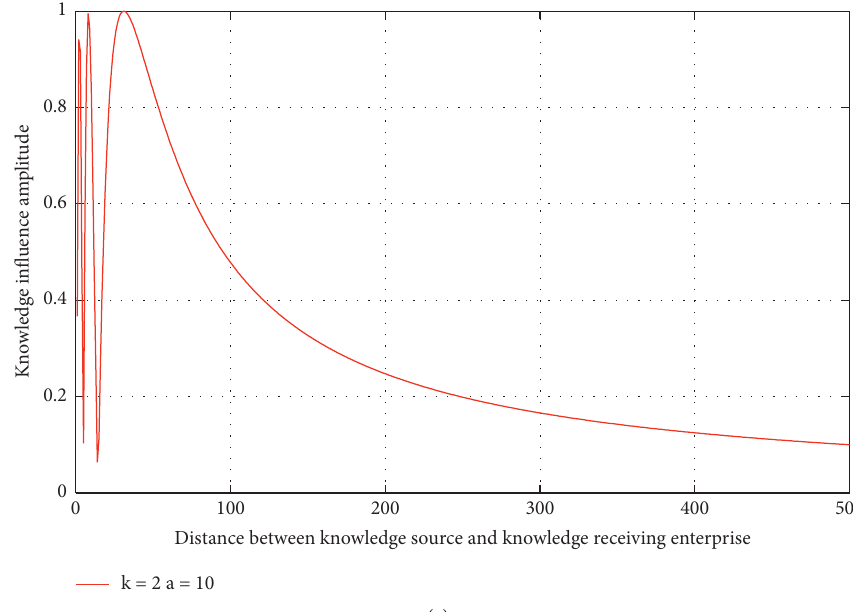
Figure 11: Distributions of the influence amplitude in the knowledge field when k � 2 and a � 2 , 5 , 10.